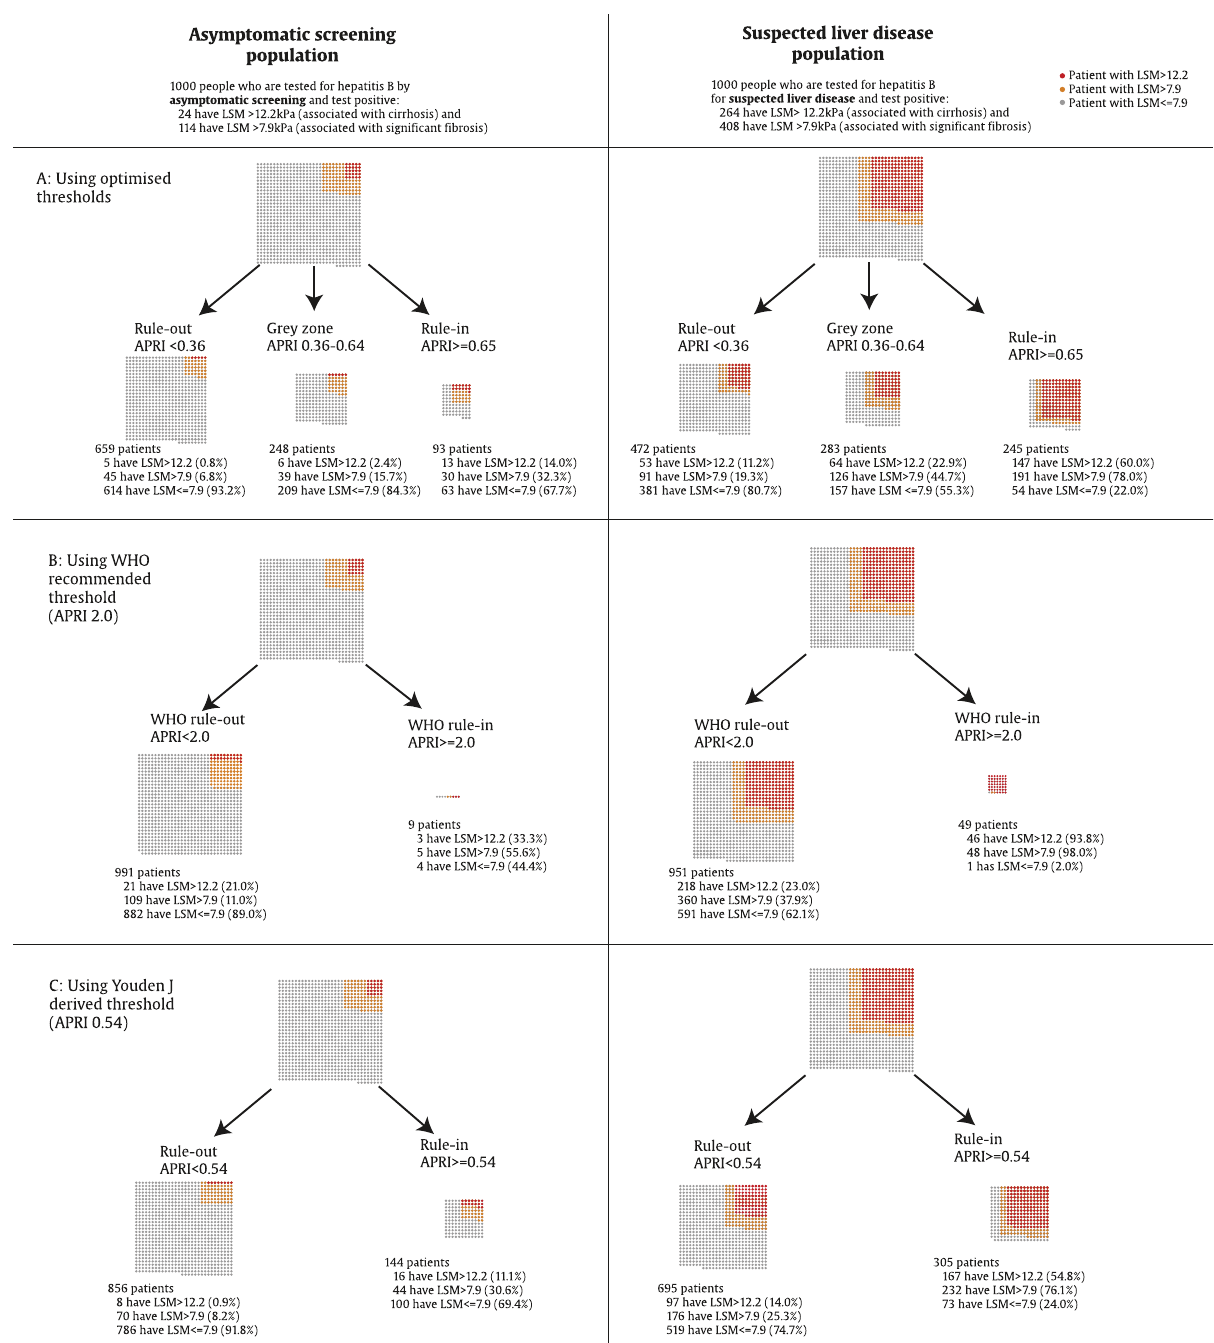
fi brosis, and one red dot represents a person with LSM>12.2kPa associated with cirrhosis (F4). Individual proportions rounded to nearest whole individual and represent the effect of applying APRI thresholds to the average populations included in the cohorts, strati fi ed byreason forhepatitisB testing. Source data are provided as a Source Data fi